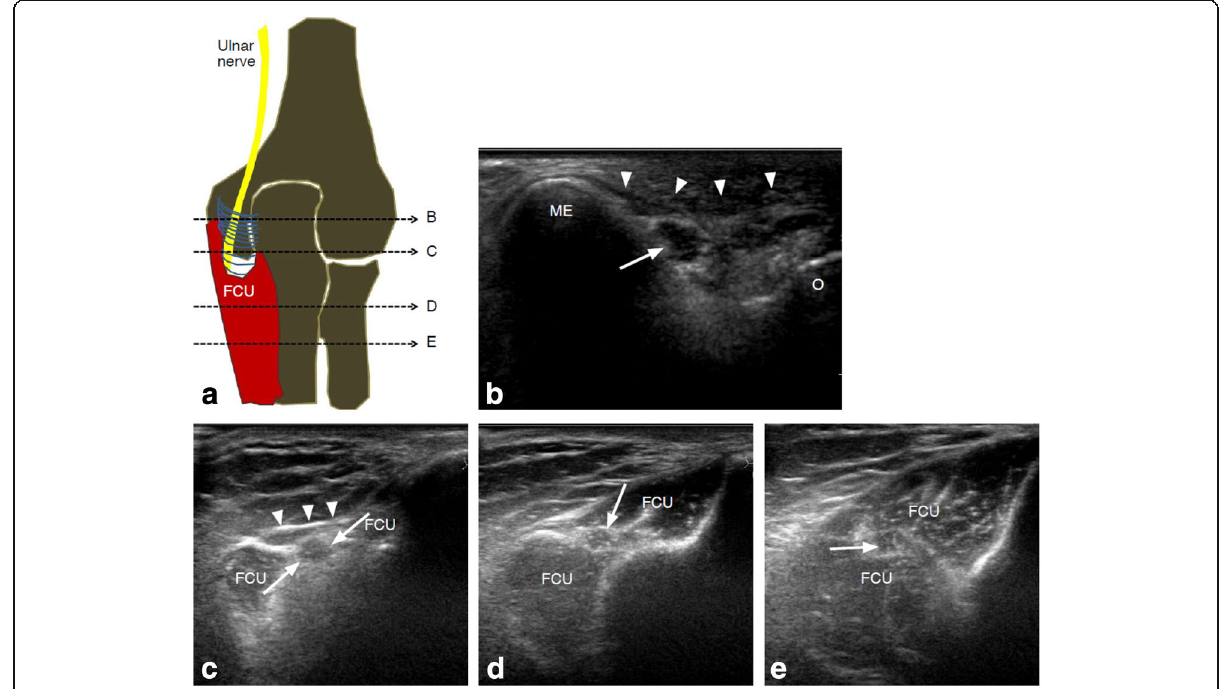
Fig. 2 The schematic representation and transverse sonograms of the normal ulnar nerve in the cubital tunnel and the proximal forearm